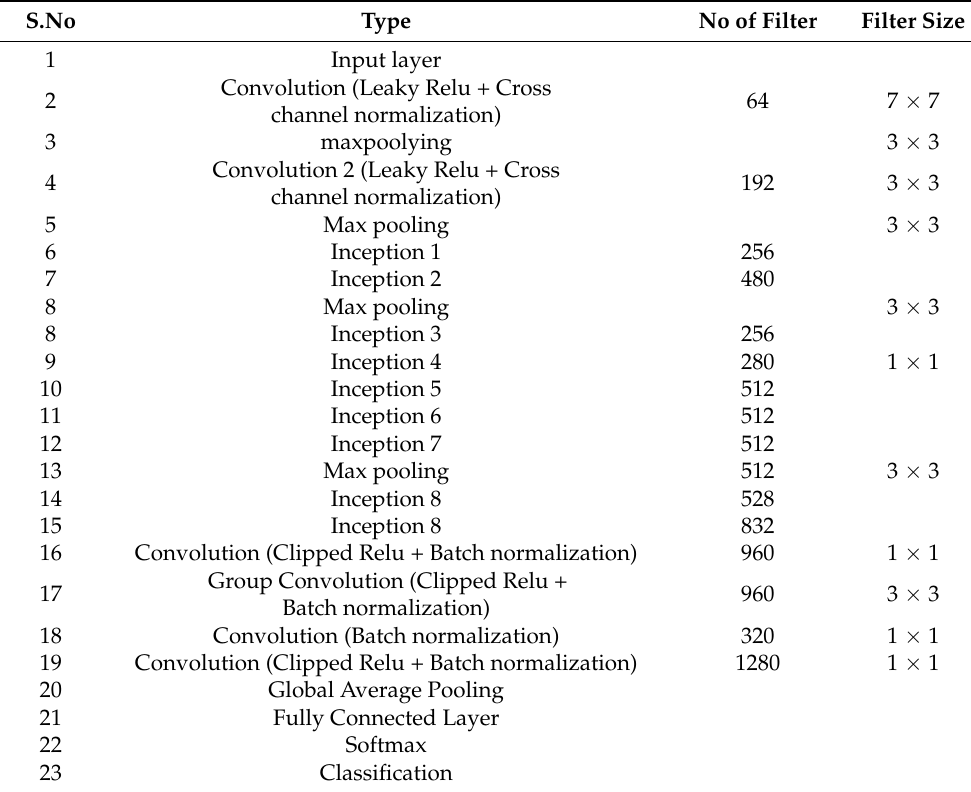
Table 2. Characteristics of the proposed DeepBreastCancerNet